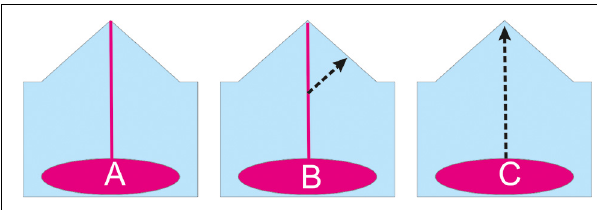
FIGURE 1 | Resistance to magma ascent is governed (A) by magma rheology at open volcanoes that maintain a connection between their feeding body and the surface, but by the strength of the crust at closed volcanoes, when a new pathway ( arrows ) must be formed before (B) a flank eruption (even when an open conduit is also available) and (C) eruptions after an extended interval of